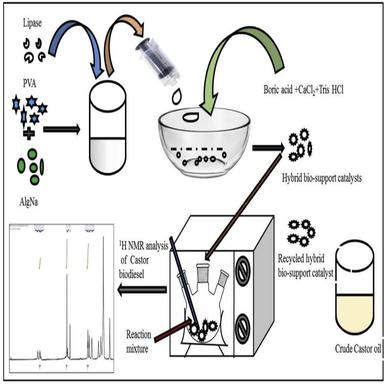
A schematic diagram of the preparation of hybrid bio-support catalyst and complete process for biodiesel production using Castor oil as a raw material.